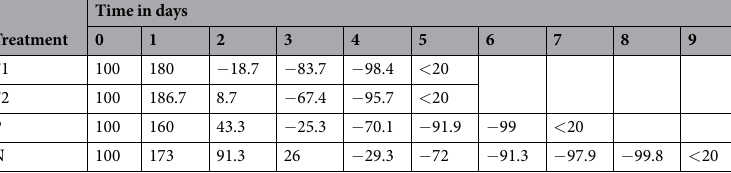
Table 4. Bacterial loads at different time points after the application of F1 or F2. Bacterial load was calculated as a % of the initial load for each site. F1: Formulation 1; F2. Formulation 2; P: Positive control, silver sulphadiazine; N: Negative control,